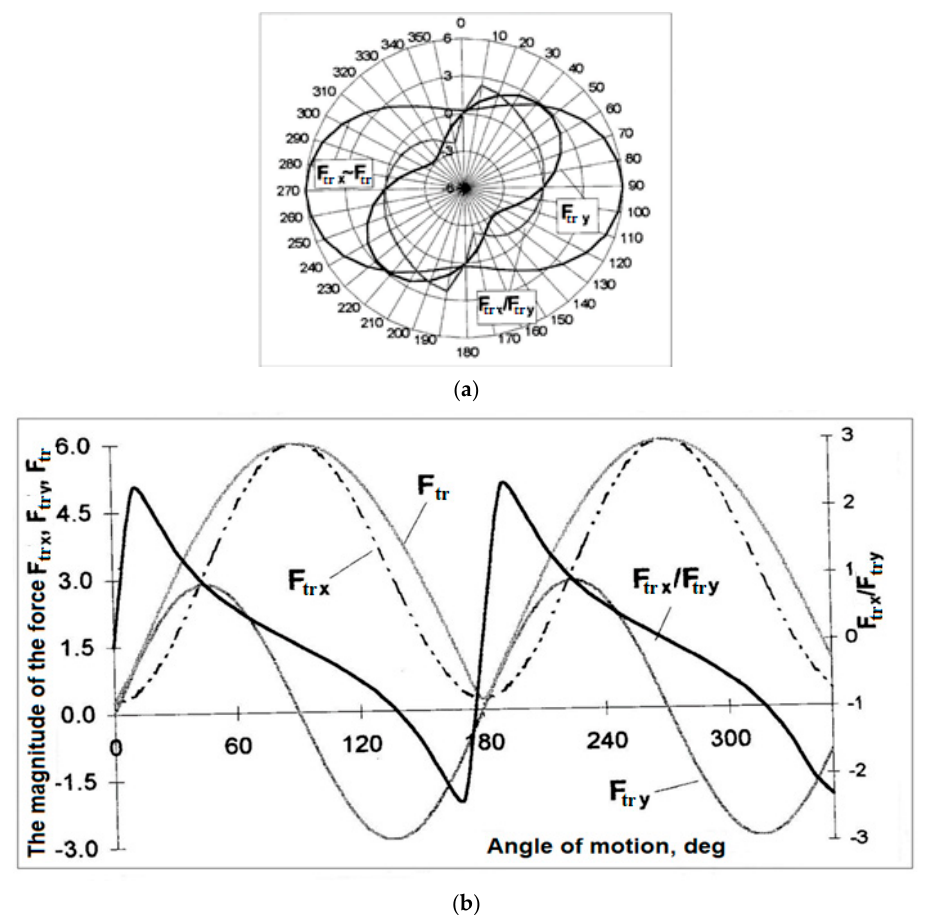
Figure 3. Change in the power characteristics of the mechanical model depending on the angle of motion in polar ( a ) and decretal ( b ) coordinates. Values F trX and F trY are projections of the friction force on the coordinate axes (Figure 1). The changes of extreme values of the angular parameters of conjunction, depending on the factor 𝑘/𝐾 , are defined from the nomogram (Figure 4).